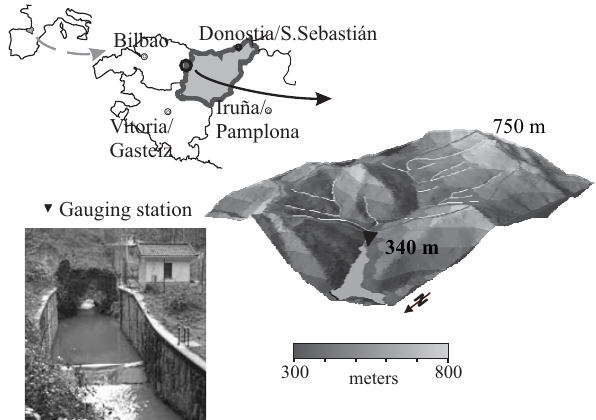
Fig. 1. Location of Aixola catchment and representation of its digital terrain